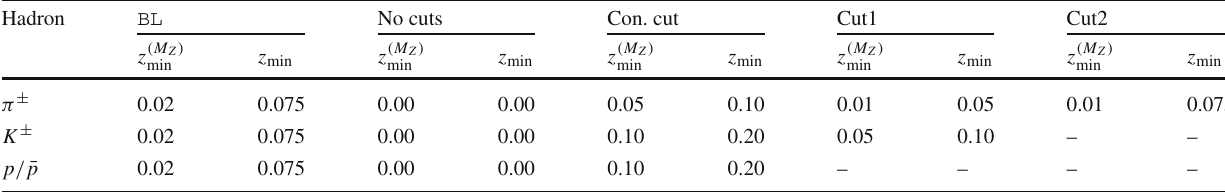
( z < z ) are excluded from the fit min min